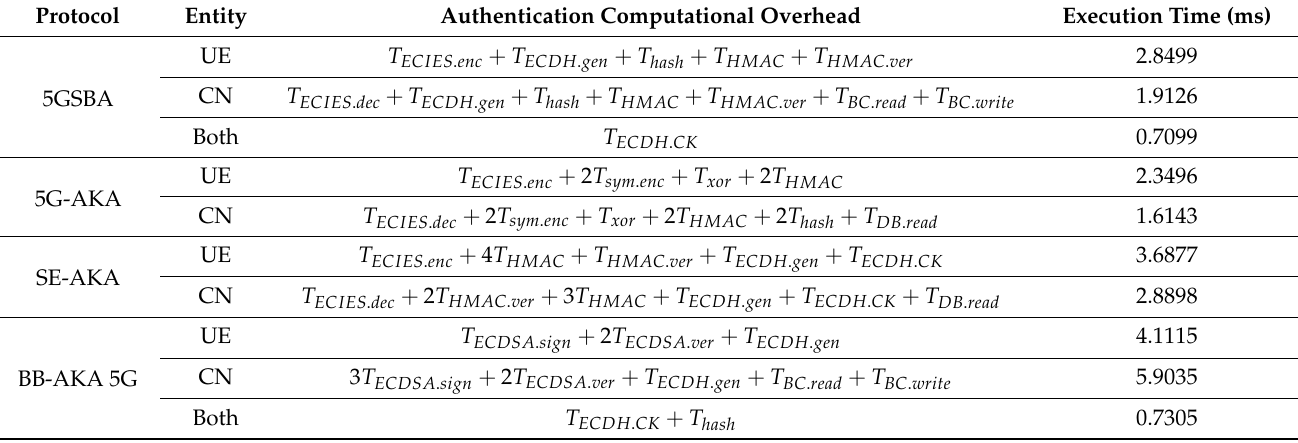
Table 5. Theoretical computational